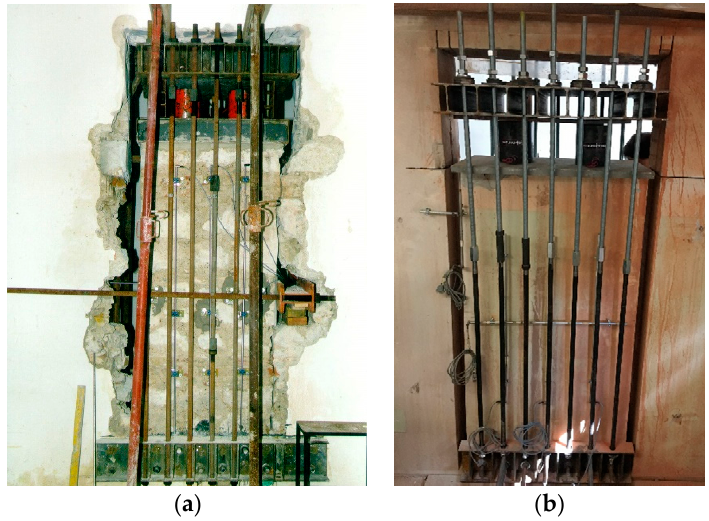
Figure 6. Instrumentation and test layout: ( a ) Diagonal tension test; ( b ) Compression test [dimensions in cm].